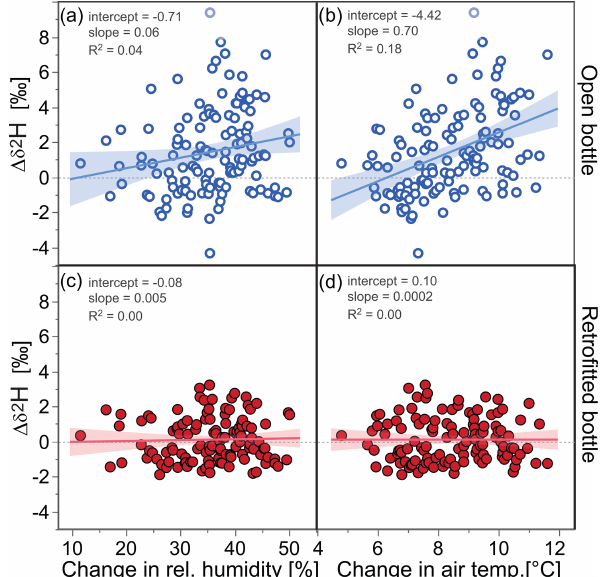
Figure 7. Deuterium differences ( (cid:49)δ 2 H) in samples stored in open and retrofitted ISCO bottles relative to a reference water and their relationships with the average vapor pressure deficits (VPDs) and the average air temperatures during the respective storage periods at the EIN and ERL sites. Samples in open bottles (open blue cir- cles) show a substantial isotopic enrichment with higher VPD and air temperature, whereas samples in retrofitted bottles (filled red cir- cles) do not indicate a systematic fractionation effect. No relation- ship with relative humidity was found. The uncertainties of the indi- vidual (cid:49)δ 2 H values were on average 0.52‰; linear regression fits are indicated by solid lines, as well as slope, intercept, and R 2 val- ues; the shaded areas represent the 95% confidence intervals of the fitted lines.